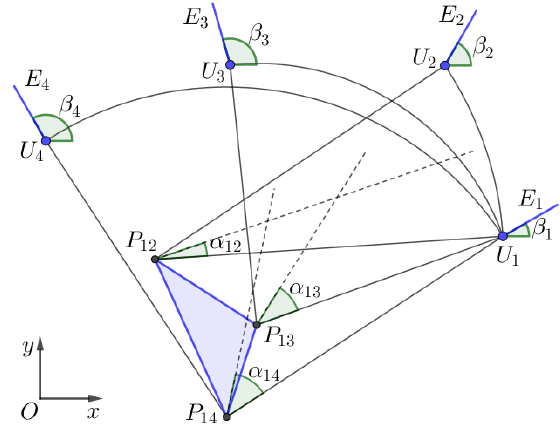
Figure 1. Motion positions and pole